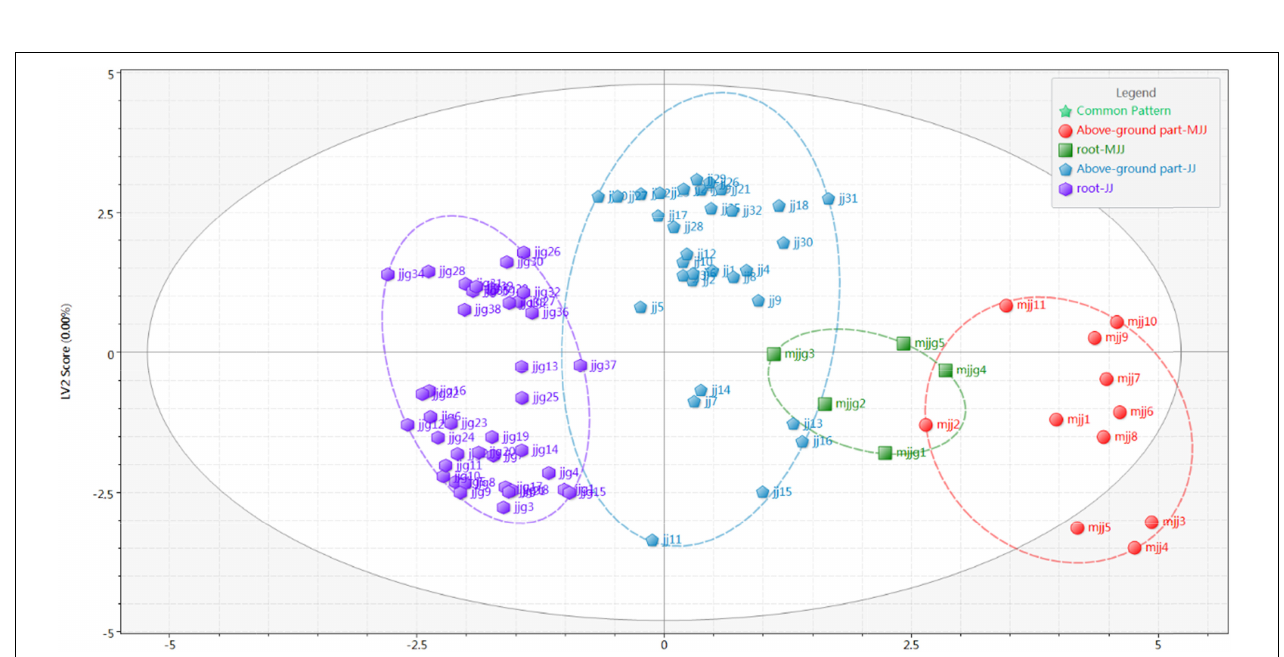
FIGURE 5 | OPLS analysis of different medicinal parts (above-ground parts and roots) of chicory.